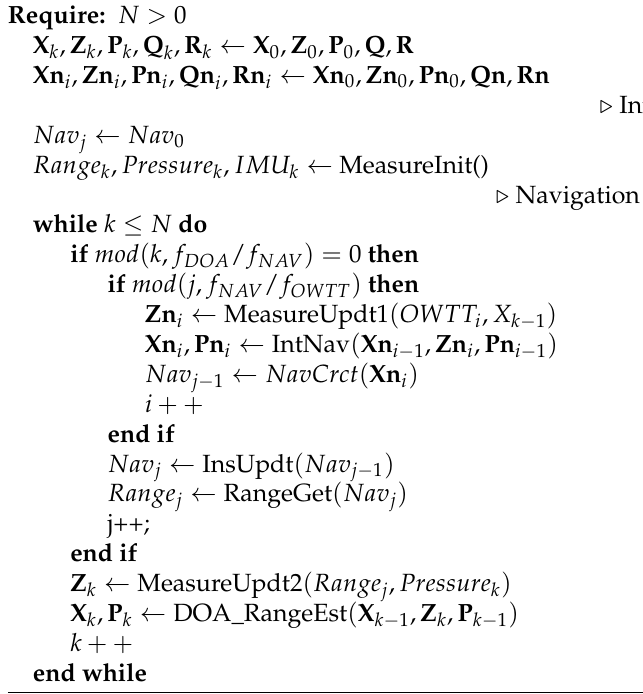
Algorithm A1 Pseudo code of the proposed